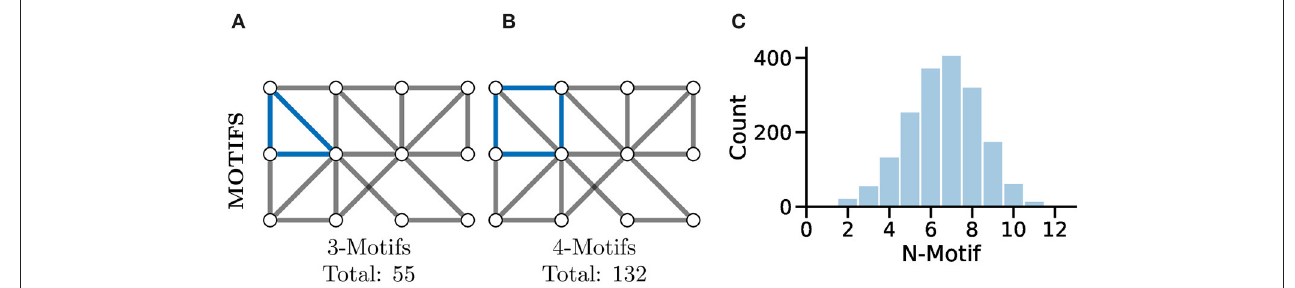
FIGURE 7 | Motifs represent repeating highly-localised topological patterns in the graph; remember, here “local” refers to directly connected nodes in the graph and not, necessarily, physically located neurons. (A) An example 3-motif in blue; there are a total of 55 3-motifs in this graph. (B) An equivalent 4-motif in blue; there are 132 4-motifs in this graph. (C) Histograms of graph motif counts can be used to create a signature or fingerprint for graphs that can then be compared between cases. Here, we see the histogram of all n-motifs in the graph used for (A,B) .